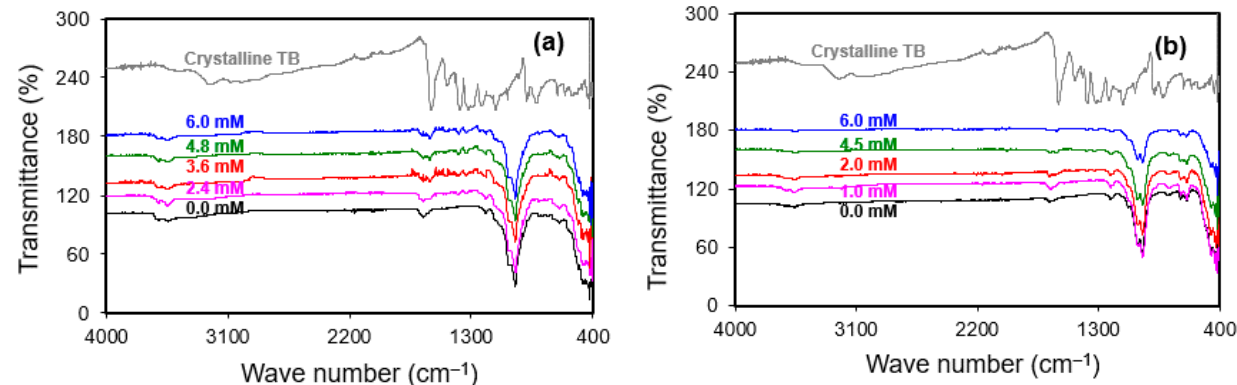
Figure 6. FTIR spectra of PAL ( a ) and SEP ( b ) after TB sorption from different initial concentrations.